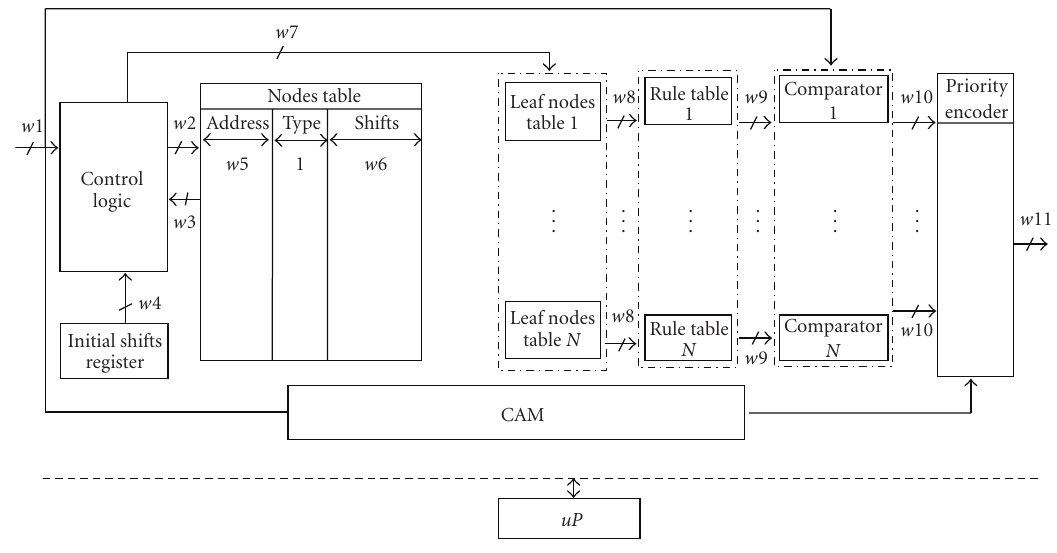
Figure 5: An architecture for multilevel